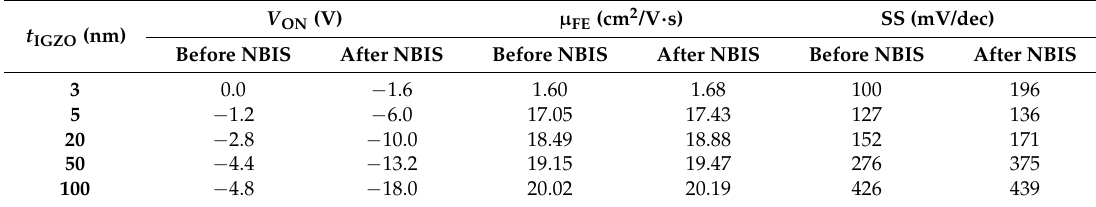
Table 1. Key thin-film transistor